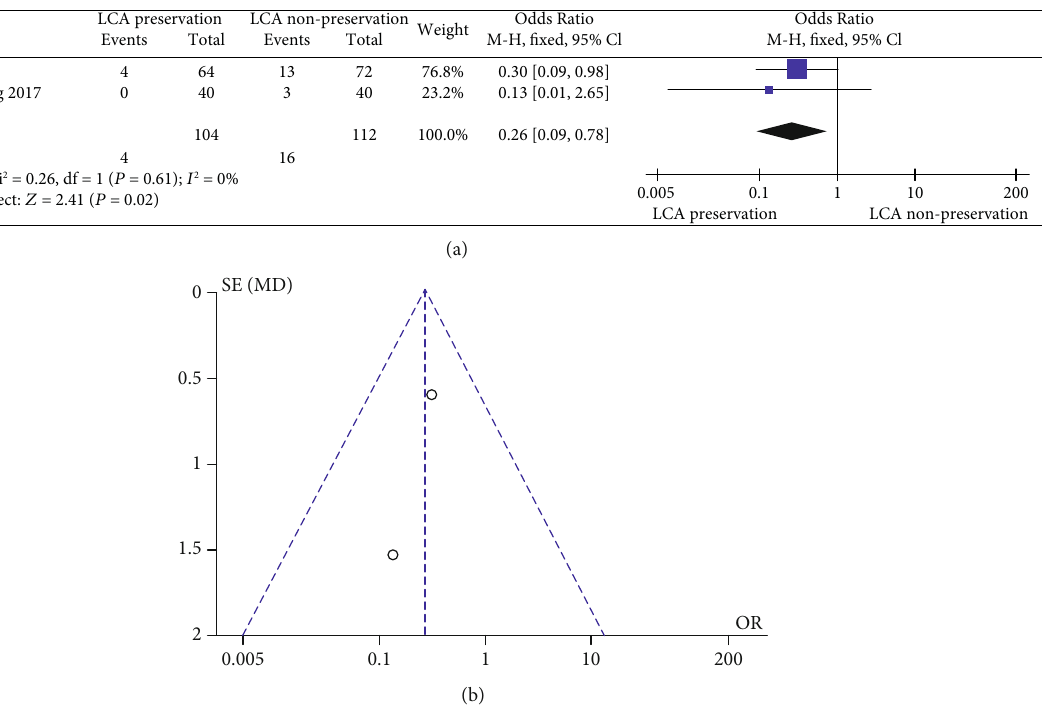
Figure 8: (a) Forest plot of postoperative urinary and sexual dysfunction; (b) funnel plot of postoperative urinary and sexual